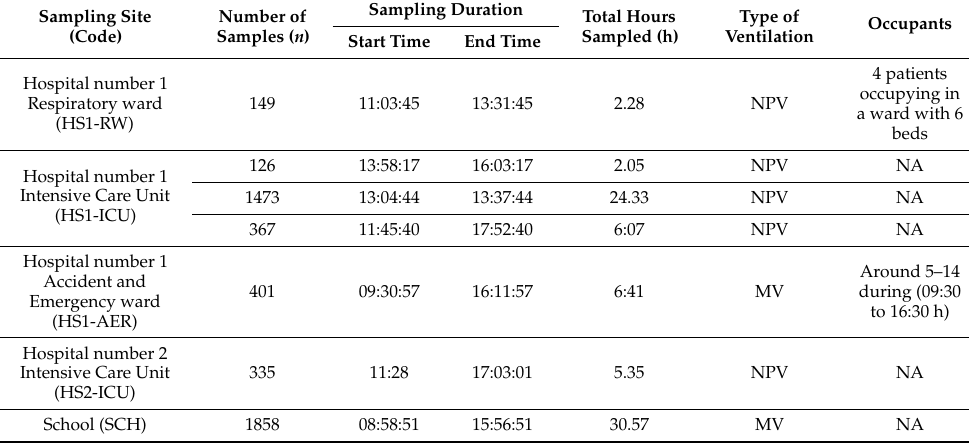
Table 2. Description of sampling site, the total number of sampling hours and the number of samples collected and the type of ventilation (NPV—Negative pressure ventilation; MV—Mechanical Ventilation, NV—Natural Ventilation) at all the sampling sites. All the sampling sites have been anonymized for confidentiality